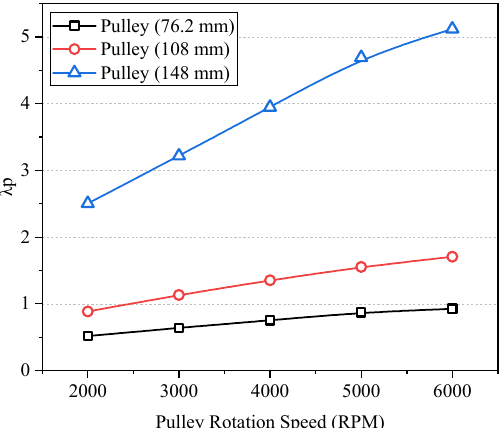
Figure 14. Air velocity around the DN pulley under a speed of 4000 RPM and torque load of 10 N ⋅ m.